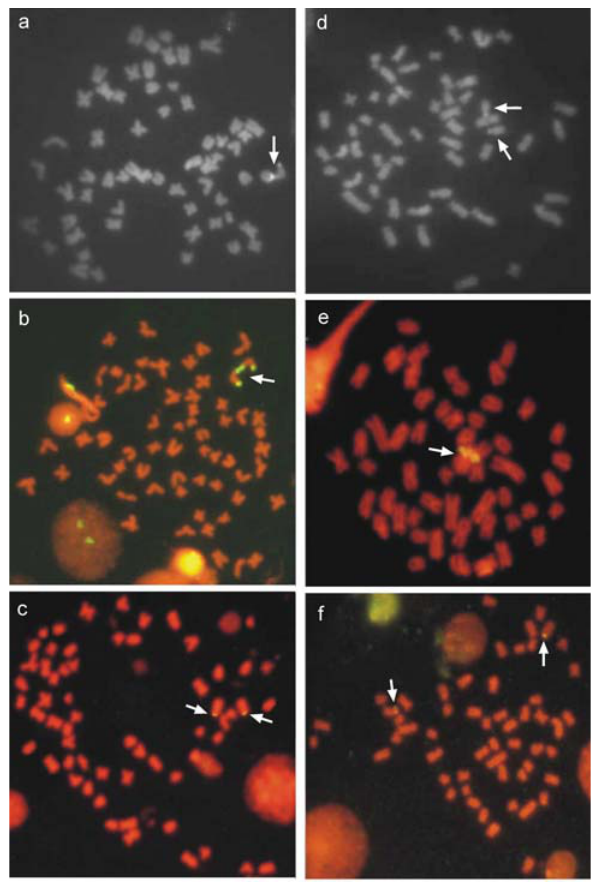
Figure 3 - Metaphases of Conorhynchus conirostris : (a) chromomycin A 3 staining, (b) 18S rDNA-FISH, and (c) 5S rDNA-FISH; and metaphases of Lophiosilurus alexandri : (d) chromomycin A 3 staining, (e) 18S rDNA- FISH, and (f) 5S rDNA-FISH. The chromosomes evidencing positive bands by chromomycin A 3 staining, and by 18S and 5S rDNA-FISH are indicated by